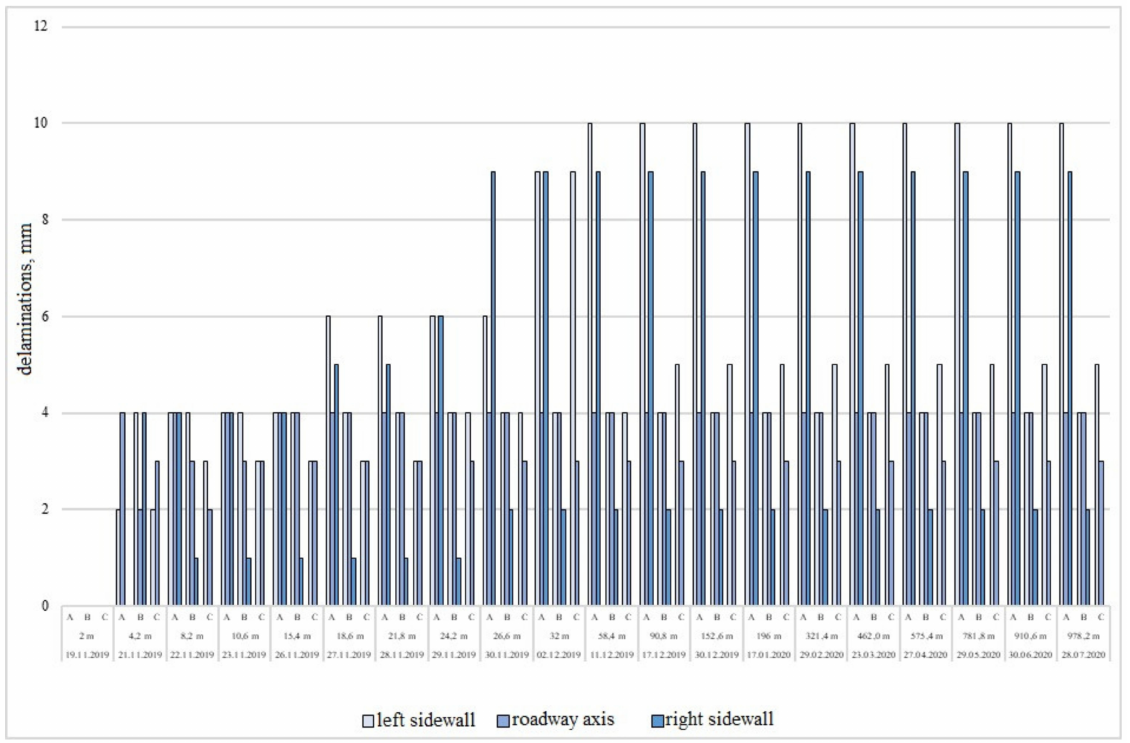
Figure 4. Roof delaminations’ values measured on the periodic control station no.